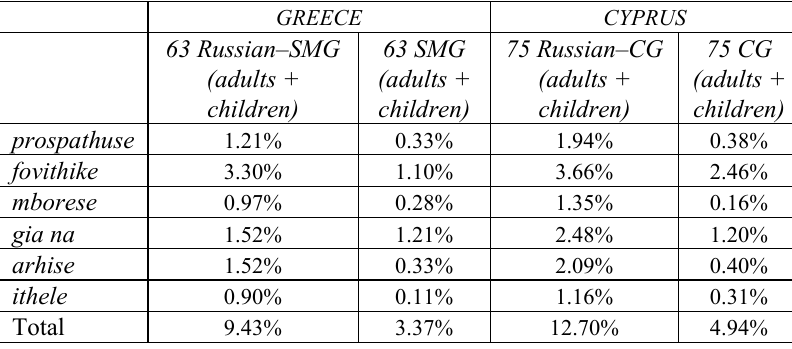
Table 4: Non-target test production of the